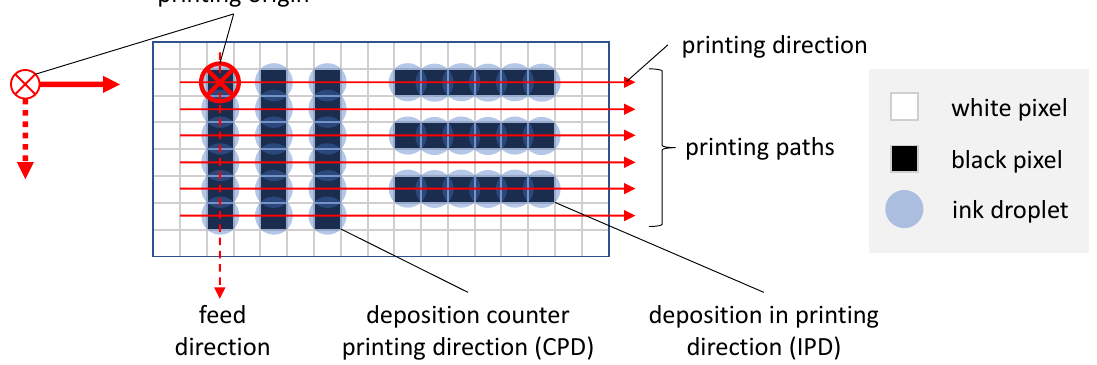
Figure 1. Printing origin, printing and feed direction of raster graphics in inkjet printing.